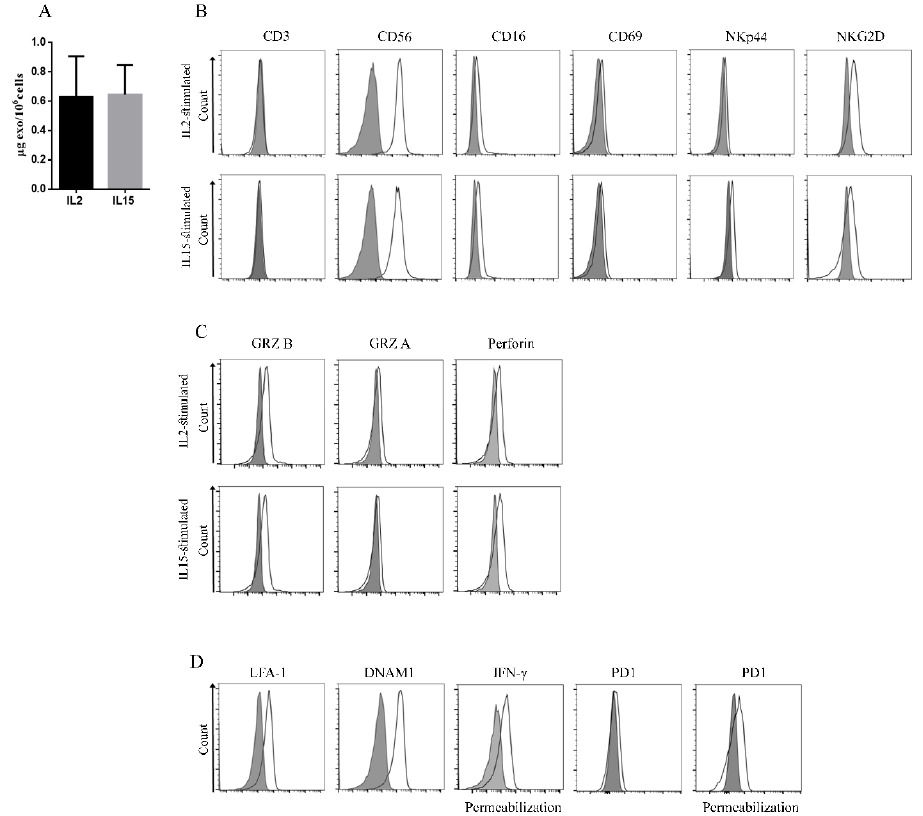
Figure 2. Phenotypic analysis of NK-derived exosomes. ( A ) Mean ± SD (standard deviation) of total amount (µg of exosomes/10 6 cells) of secreted exosomes by IL2- and IL15-stimulated NK cells after 48 h of culture ( n = 3). ( B – D ) Flow-cytometry analysis of indicated markers (black lines) on exosomes isolated from IL2- and IL15-stimulated NK cells. Filled grey profiles represent controls. One representative experiment out of 3 performed is shown. ( B ) Evaluation of surface antigens in NK-derived exosomes. ( C ) Analysis of cytotoxic proteins present inside NK-derived exosomes by flow-cytometry. ( D ) Expression of novel surface and inner markers in exosomes from IL2-stimulated NK cells by flow-cytometry (LFA-1, DNAM1, IFN- γ and PD1).